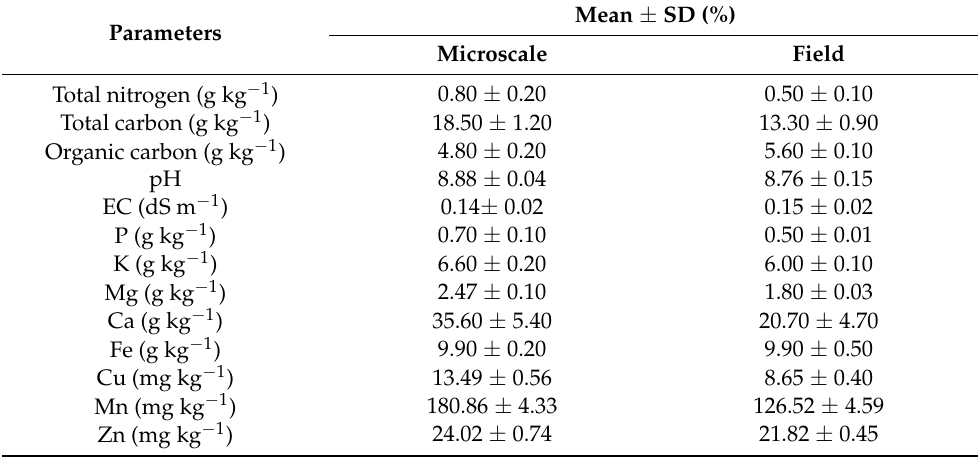
Table 5. Characteristics of the soil used in the experimental analysis from the first 15 cm of soil surface. Data on total nitrogen, total carbon and organic carbon, pH, electrical conductivity (EC), and other macro and micronutrients are shown. Values are means ± SD ( n = 5) at the beginning of the